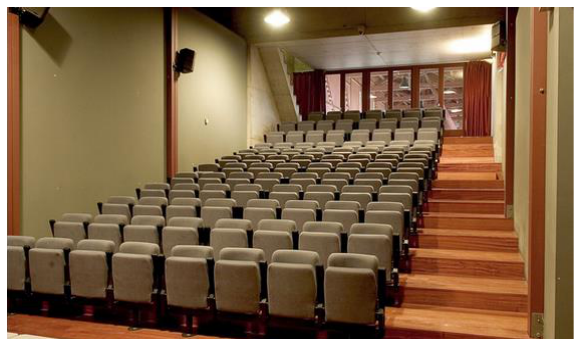
Figure 13. Right: frontal view of Student Residence from the road, and former workers’ houses crossing the Couros River.